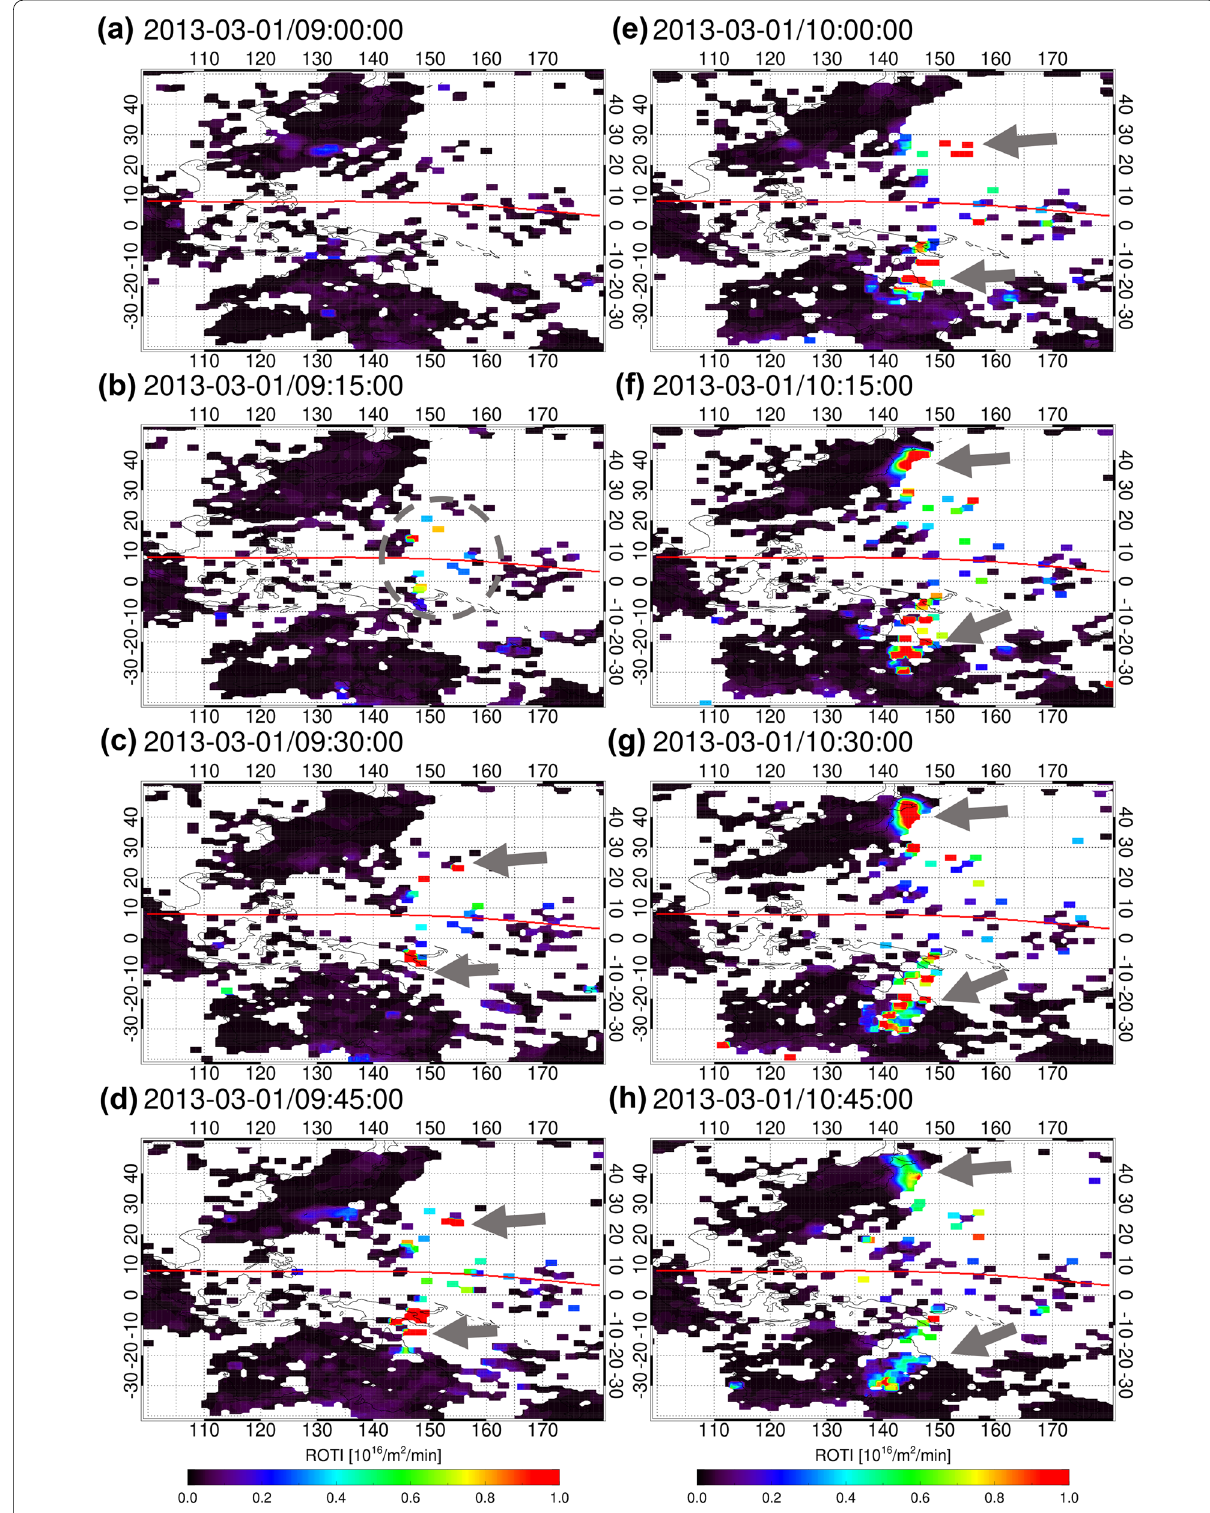
Fig. 2 a – f Two-dimensional maps of ROTI near Japan and Australia showing 15-min intervals from 09:00–10:45 UT on March 1, 2013. The red curve in each panel indicates the dip equator at a height of 300 km calculated with the IGRF-13 model. The dotted circle and arrows in panels b – h show the location of ROTI enhancements, respectively. The color code indicates the ROTI value within a range of 0.0 to 1.0